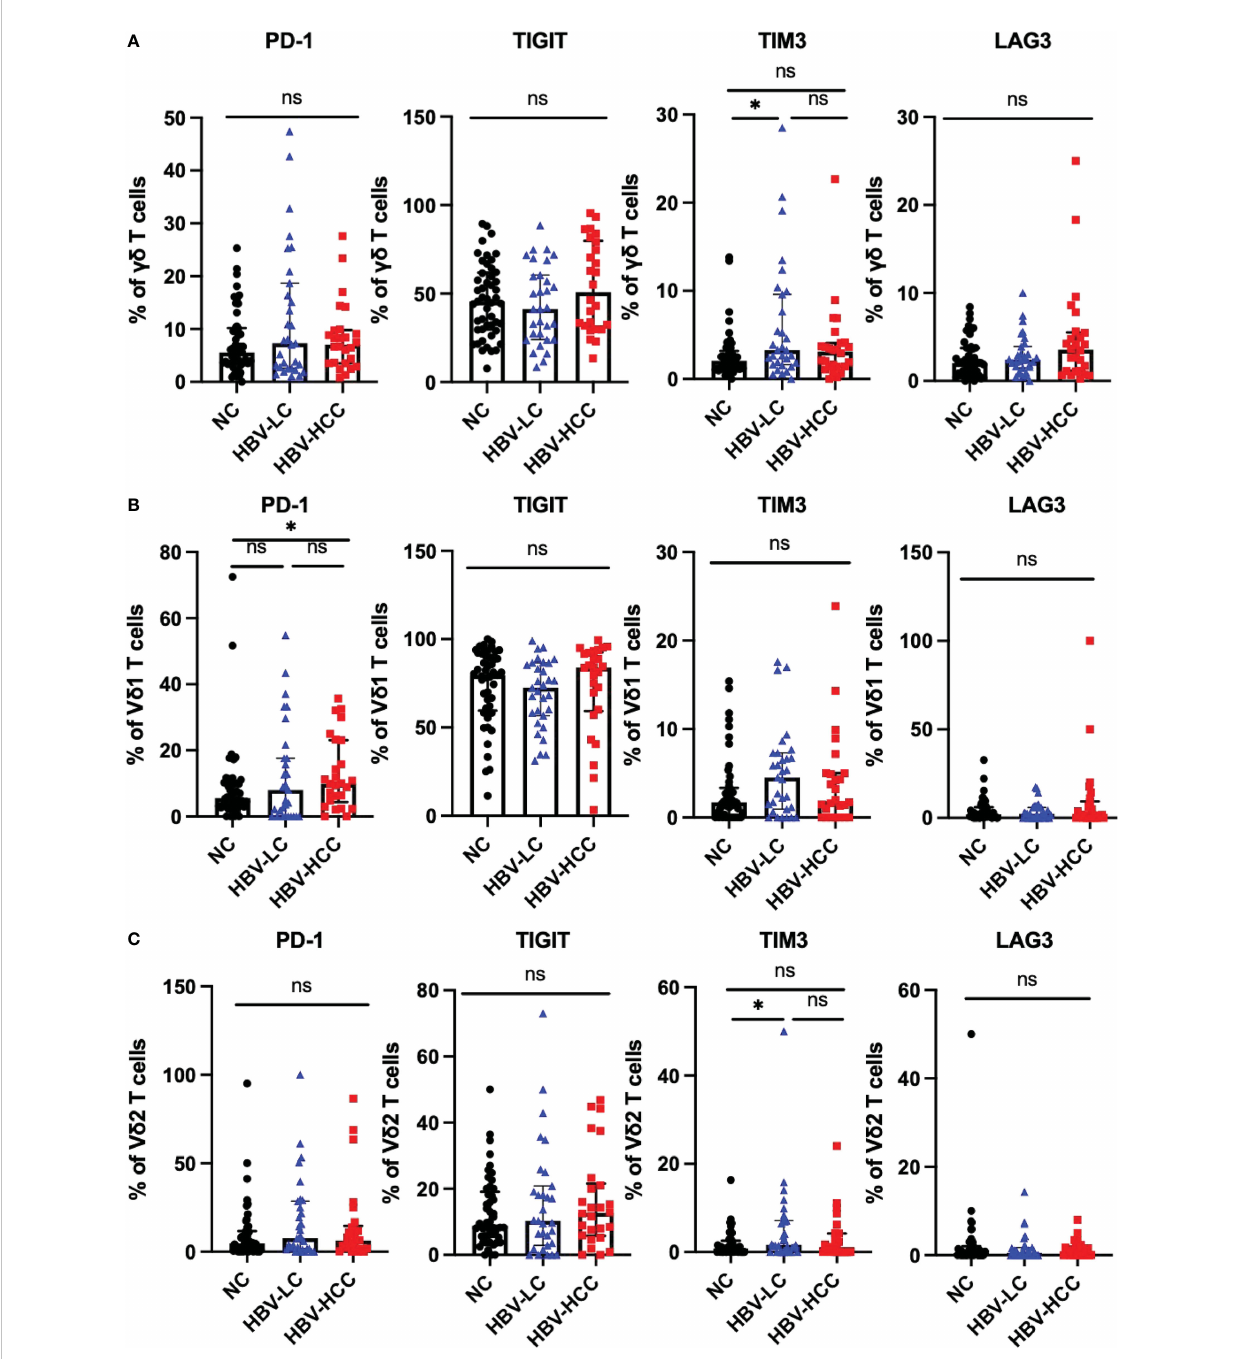
FIGURE 4 Expression of inhibitory receptors on gd T cells. (A) Expression of PD-1, TIGIT, TIM3 and LAG3 on the surface of gd T cells. (B) The expression of PD- 1, TIGIT, TIM3 and LAG3 on the surface of V d 1 cells. (C) The expression of PD-1, TIGIT, TIM3 and LAG3 on the surface of V d 2 cells. * p